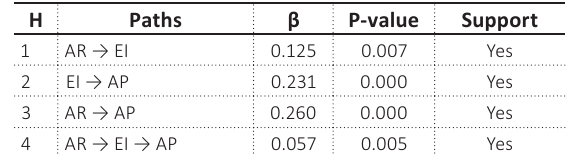
Table 2. Structural model